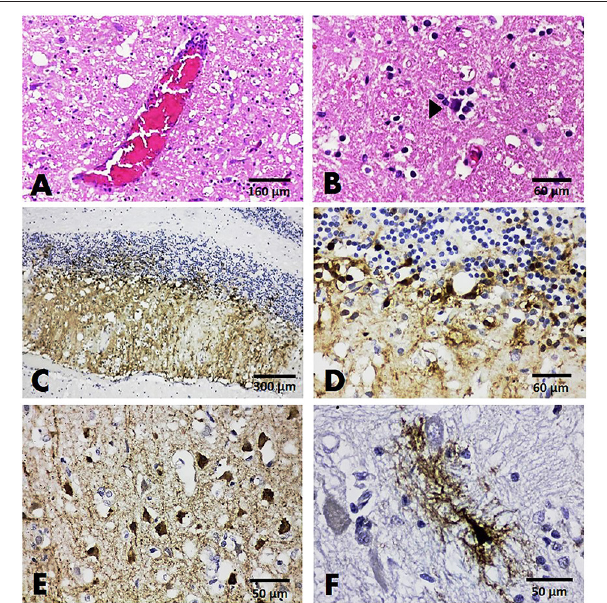
FIGURE 3 | Brain, dog. HandE sections showing mild perivascular cuffing (A) and satellitosis (arrowhead) (B) . IHC slides showing positive immunoreactivity to the CDV antigen in the cells comprising cerebellar gray matter (C,D) , in small neurons (E) , and in the glial cells resembling astrocytes (F) of the cerebral